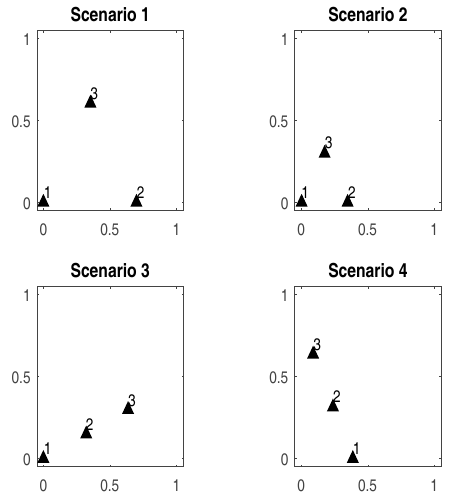
Figure 8. Layout of the hypothetical wind farm designs.